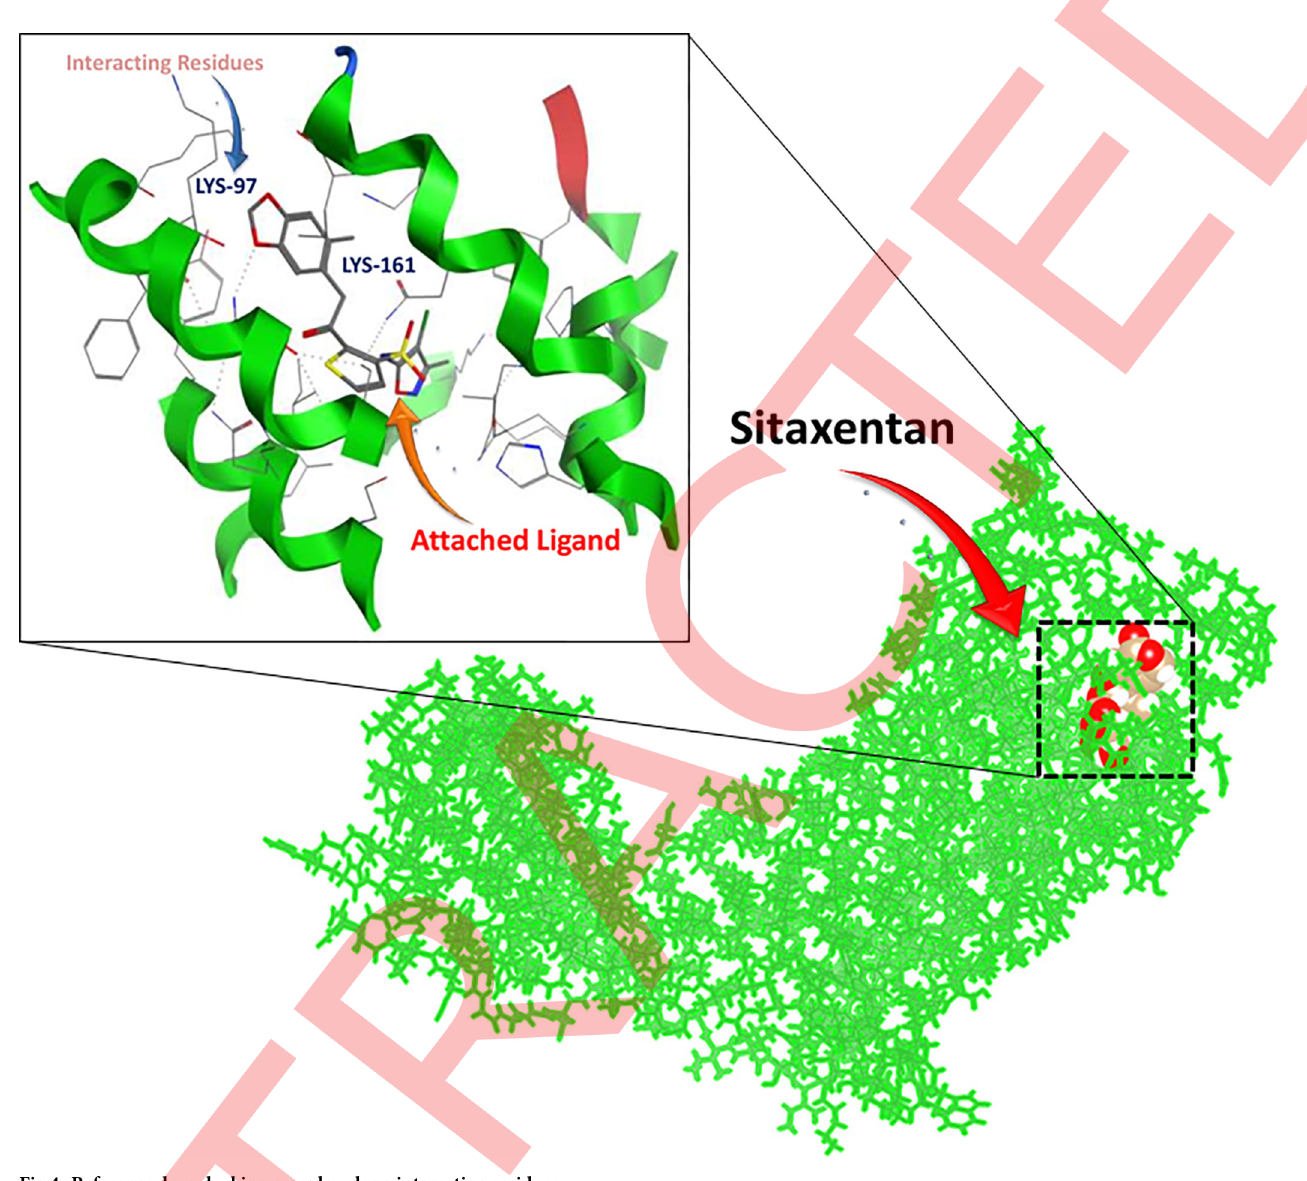
Fig 4. Reference drug docking complex along interacting residues.